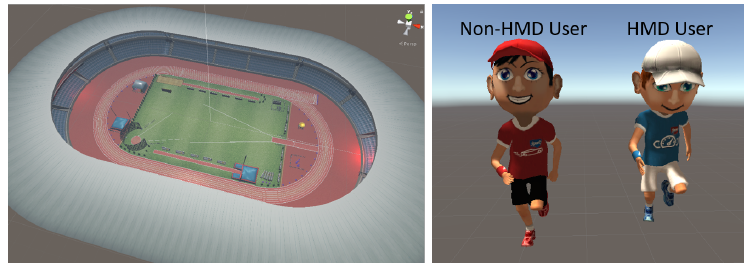
Figure 9. Environment and characters of the racing game